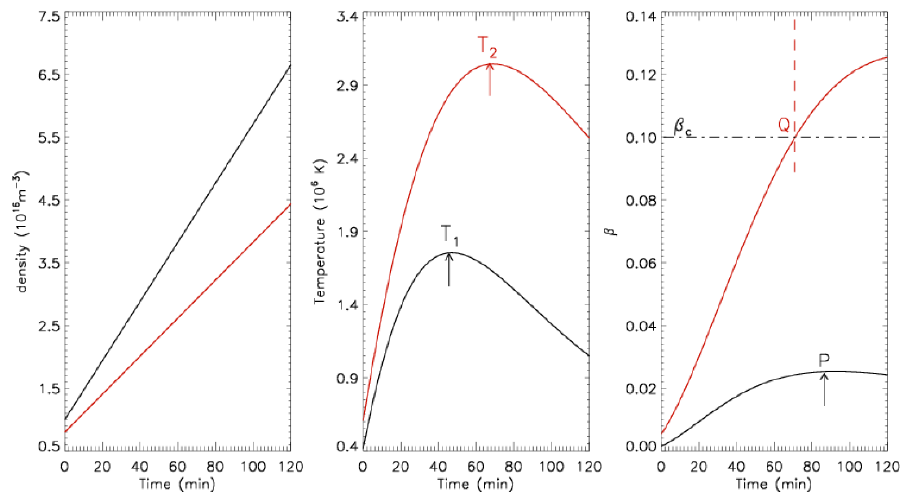
Figure 2. The temporal evolution of the plasma density (left), temperature (middle), and β value (right) in two cases. In Case 1 (black curves), we assume the initial density n ( H ) = 1.0 × 10 16 m − 3 at height H = 2 × 10 7 m. In case 2 (red curves), we assume the initial density n ( H ) = 0.8 × 10 16 m − 3 at height H = 3 × 10 7 m. Here, we adopt the model of magnetic field of Dulk and McLean [25] to derive the magnetic field (about 101 Gauss in Case 1 and 56 Gauss in Case 2), magnetic scale length ( L B ), and the starting energy ( (cid:101) o , 35.9 eV in Case 1 and 52.3 eV in Case 2) of the upward energetic